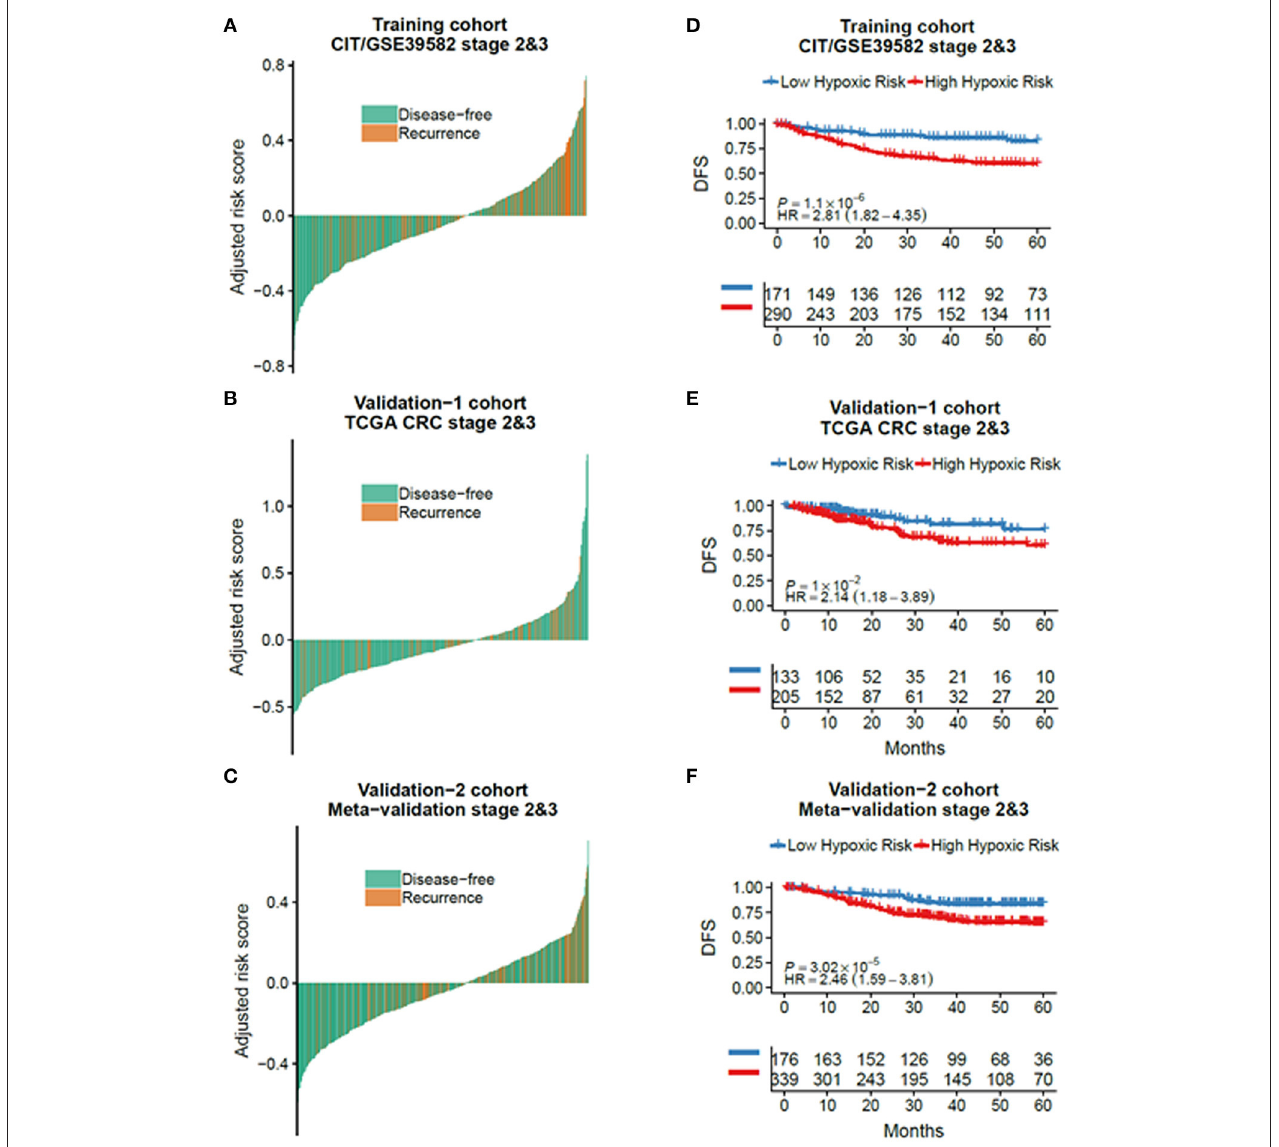
FIGURE 2 | The outcome of low and high hypoxic risk in stage II/III CRC patients. The disease-free and recurrence patients in the different hypoxic risk groups of training cohort (A) , TCGA cohort (B) , and metavalidation cohort (C) . Kaplan–Meier curves comparing patients with low or high hypoxic risk in training cohort (D) , TCGA cohort, (E) and metavalidation cohort (F) . P values were calculated using log-rank tests. HR, hazard ratio.